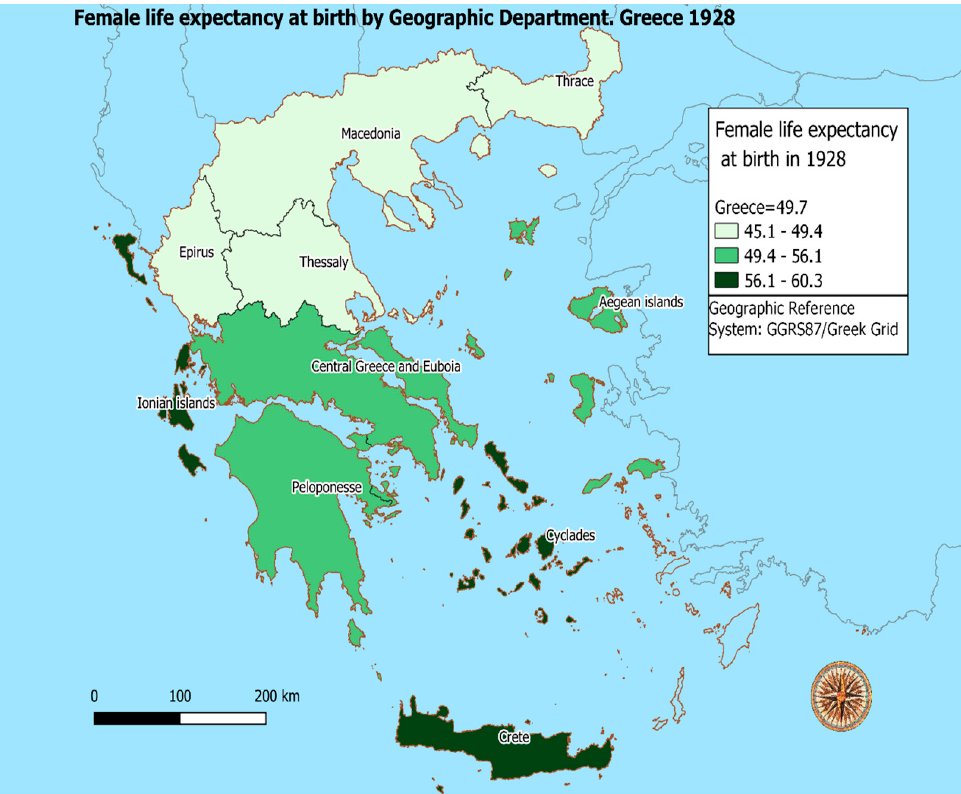
Figure 3. Map 1, Female life expectancy by Geographical Department. Greece 1928.